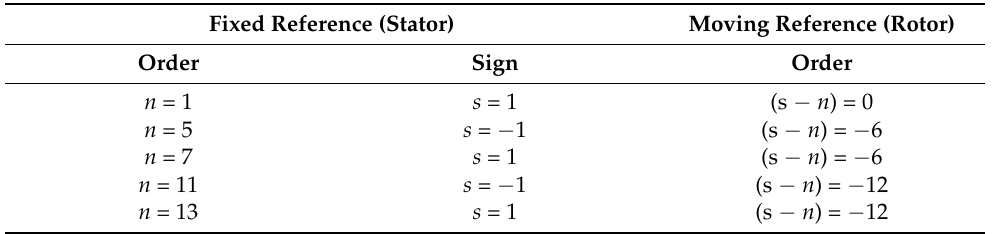
Table 4. Flux density harmonics created by the armature referenced to the stator and to the rotor in the Qs48p8 machine.